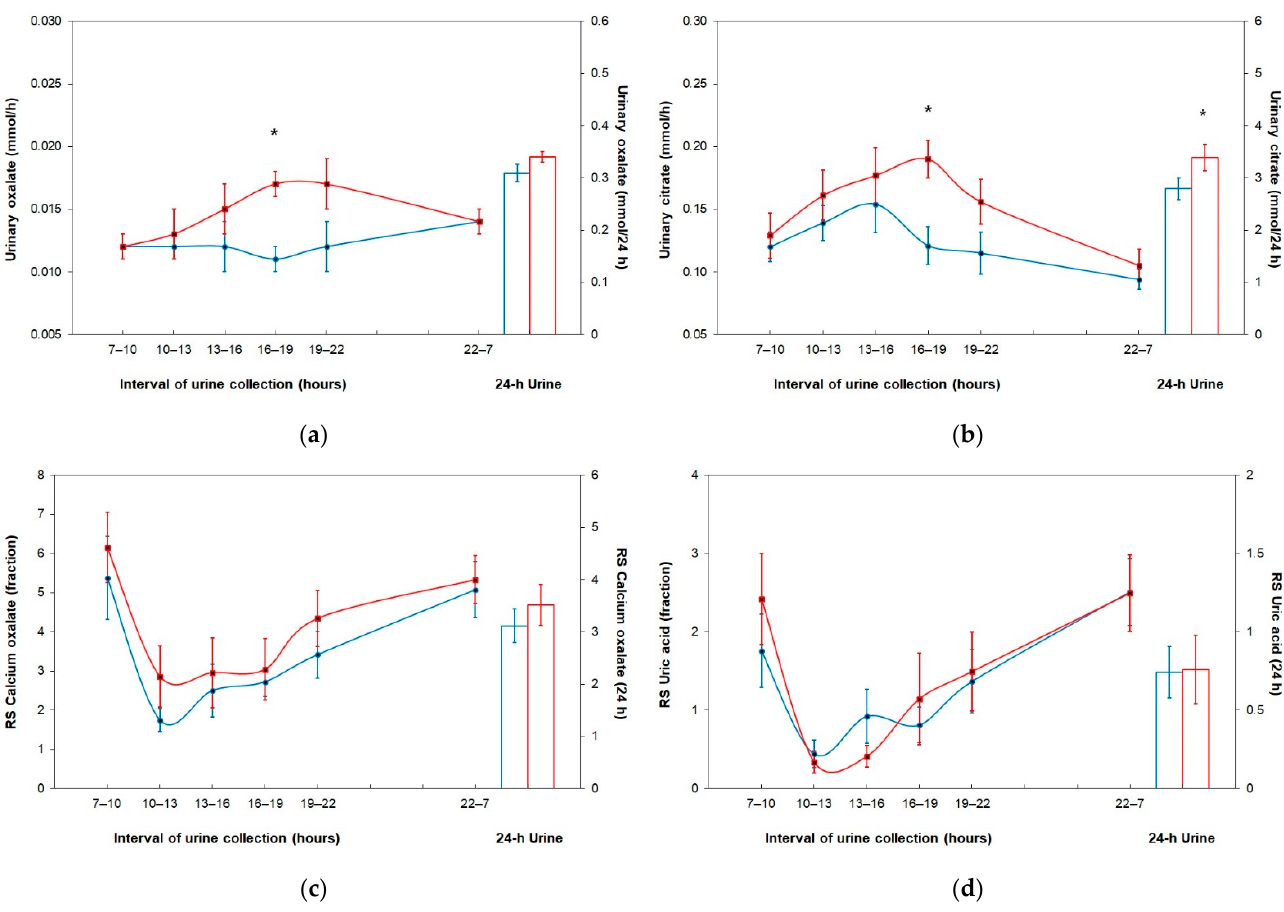
Figure 1. Fractional and 24-h urine parameters after the consumption of fruit tea (control day, blue line) and black tea (test day, red line); data are represented as M ± SEM. ( a ) Urinary oxalate excretion; ( b ) urinary citrate excretion; ( c ) relative supersaturation of calcium oxalate; ( d ) relative supersaturation of uric acid. Abbreviation: RS, relative supersaturation. * Wilcoxon test within groups: <0.05